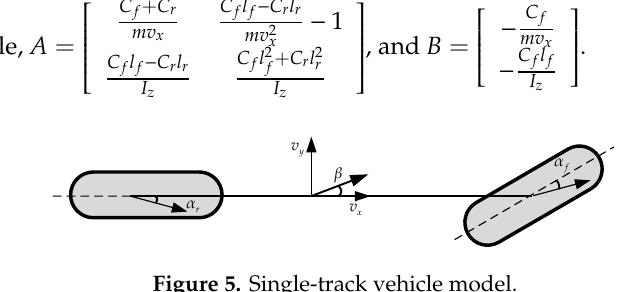
Figure 5. Single-track vehicle model.